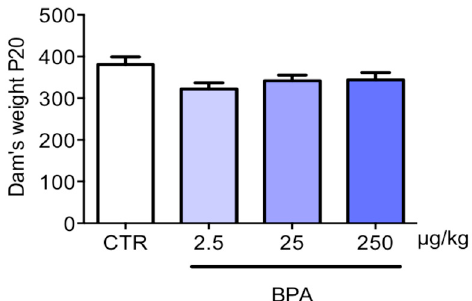
Figure 1. Dams’ weight after BPA exposure. Pregnant rats were exposed to three different doses of BPA (2.5- 25- 250 µg/kg/day) or vehicle (CTR) via drinking water, starting 30 days before the beginning of pregnancy until their sacrifice at GD 20. Weights were measured at the end of the experiments. Statistical analysis was carried out by one-way ANOVA. n = 7 for each experimental group. Table 1. Plasma lipid content in dams drinking vehicle or BPA.